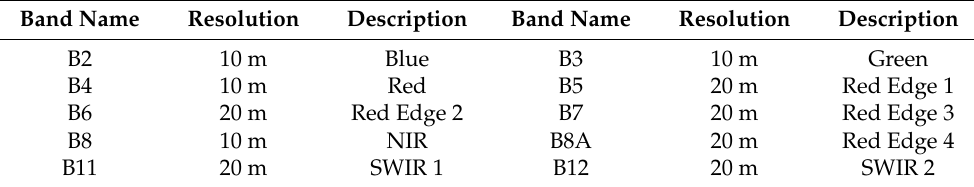
Table 1. The wavelength bands used in the Sentinel-2